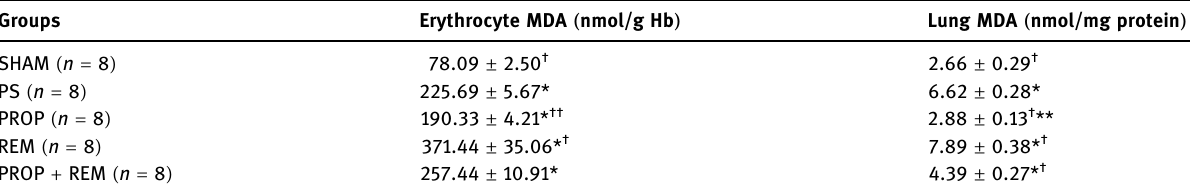
Table 1: MDA levels in lung tissues and RBC